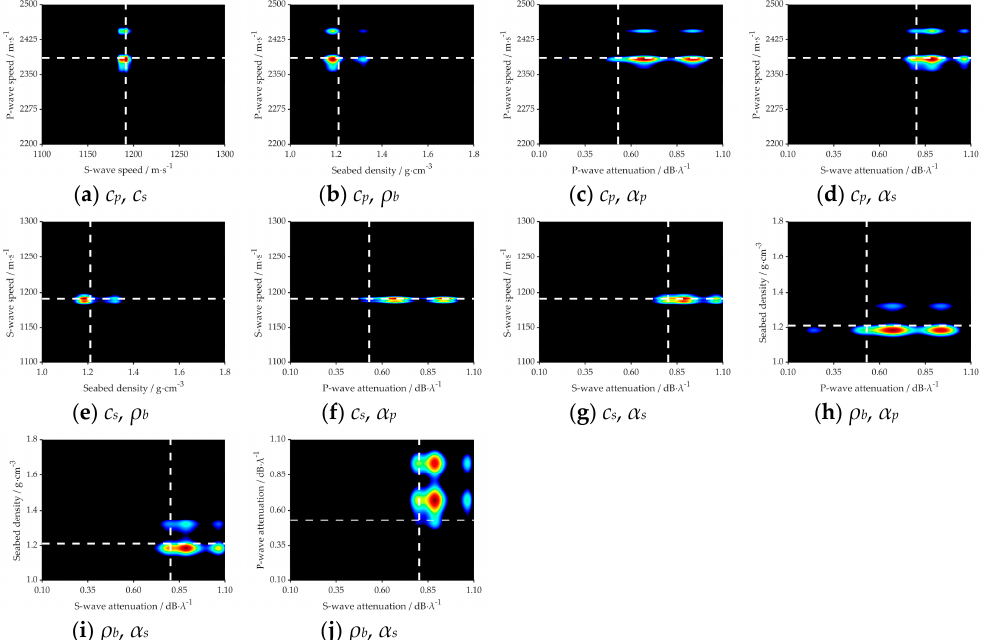
Figure 15. 2D marginal PPDs between different parameters. White dashed lines mark the Genetic Algorithm (GA) results of each parameter.